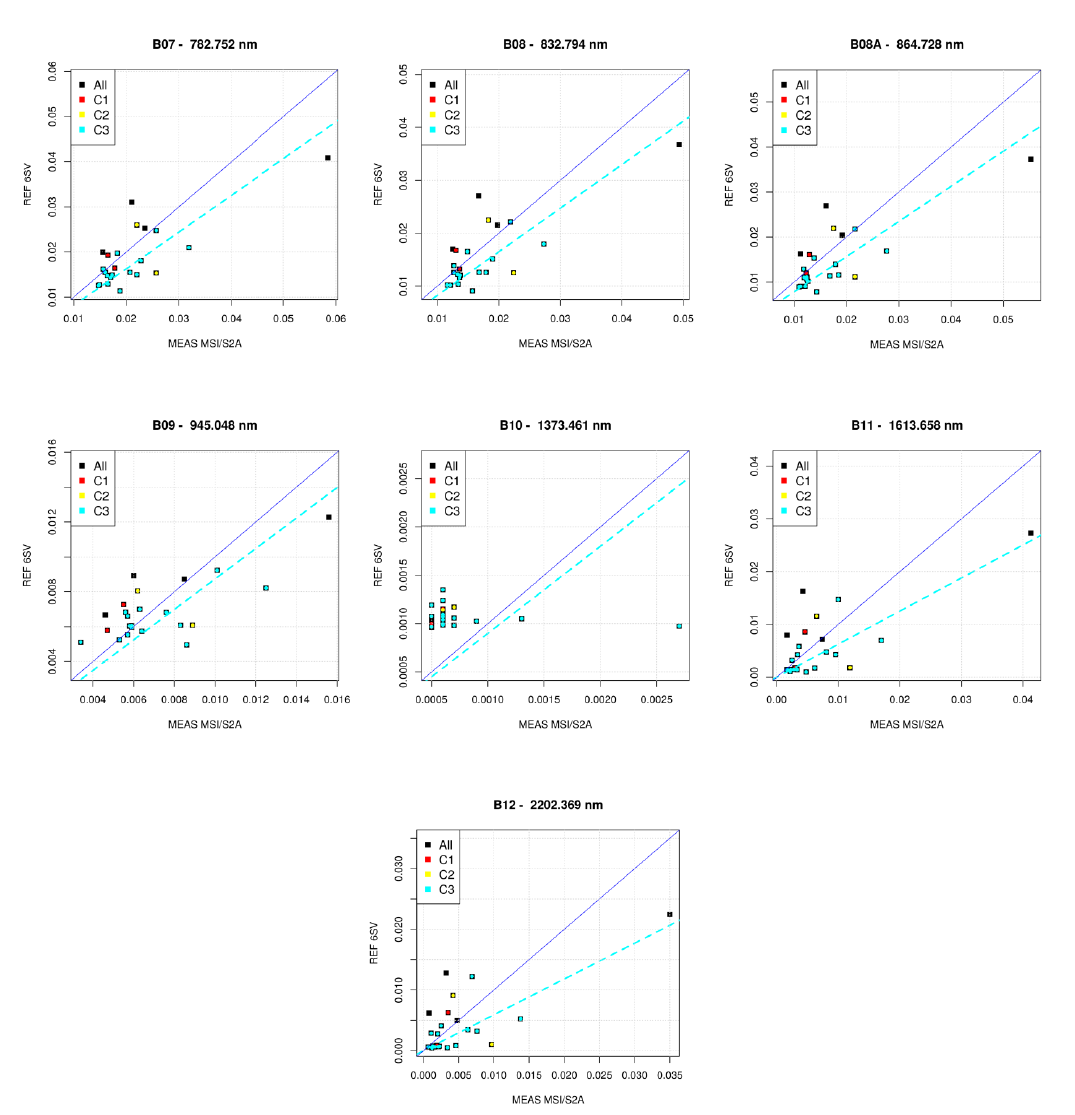
Figure 6. The TOA reflectance simulated by 6SV vs. the measured TOA reflectance for each MSI/S2A band. The red points (C1) are the data removed by the first screening, the yellow points (C2)) are the data removed by the second screening, and the cyan points (C3) are the 15 final values used for gains retrieval.